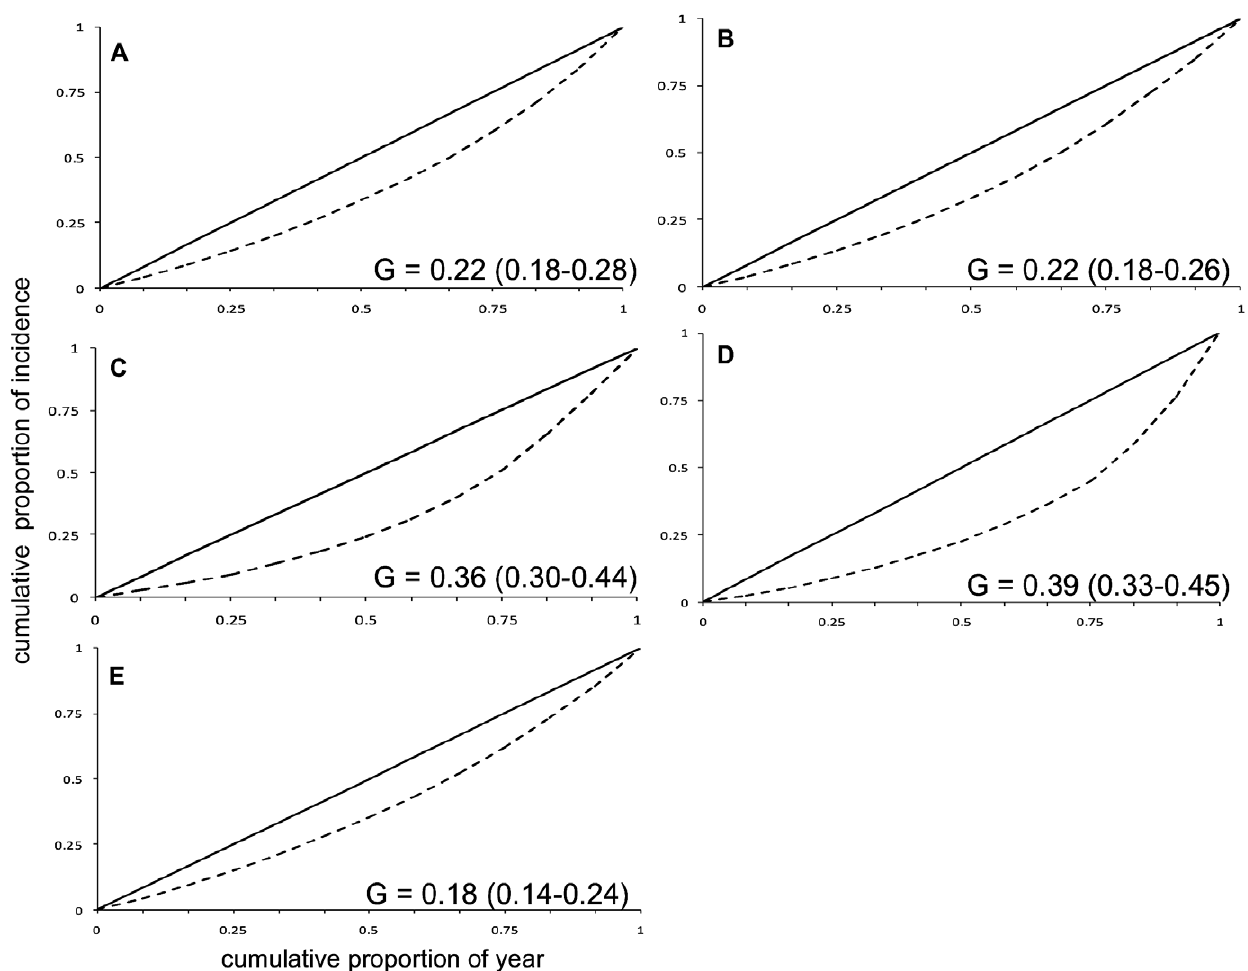
Figure 2. The Lorenz curves and corresponding Gini co-efficient for each disease. Disease curves showing cumulative distribution of disease incidence as a function of proportion of the year. The solid black line represents equal incidence through the year, and the dotted line represents the cumulative incidence. (A-campylobacteriosis, B-salmonellosis, C-VTEC, D-cryptosporidiosis, E-giardiasis).